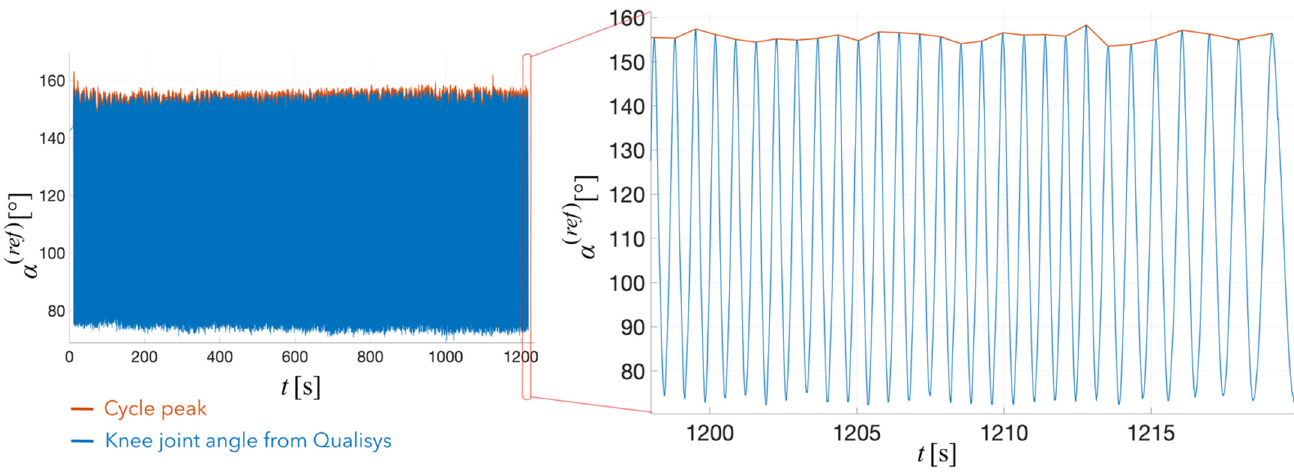
Figure 5. Example knee joint angle results. Maximum values are used to split the measurements into cycles. The cycles are then used for cadence, maximum angle, and average RMSE computation. Table 1. The subjects’ average cadence with the maximum and minimum knee joint angles as measured with the reference optical motion tracking